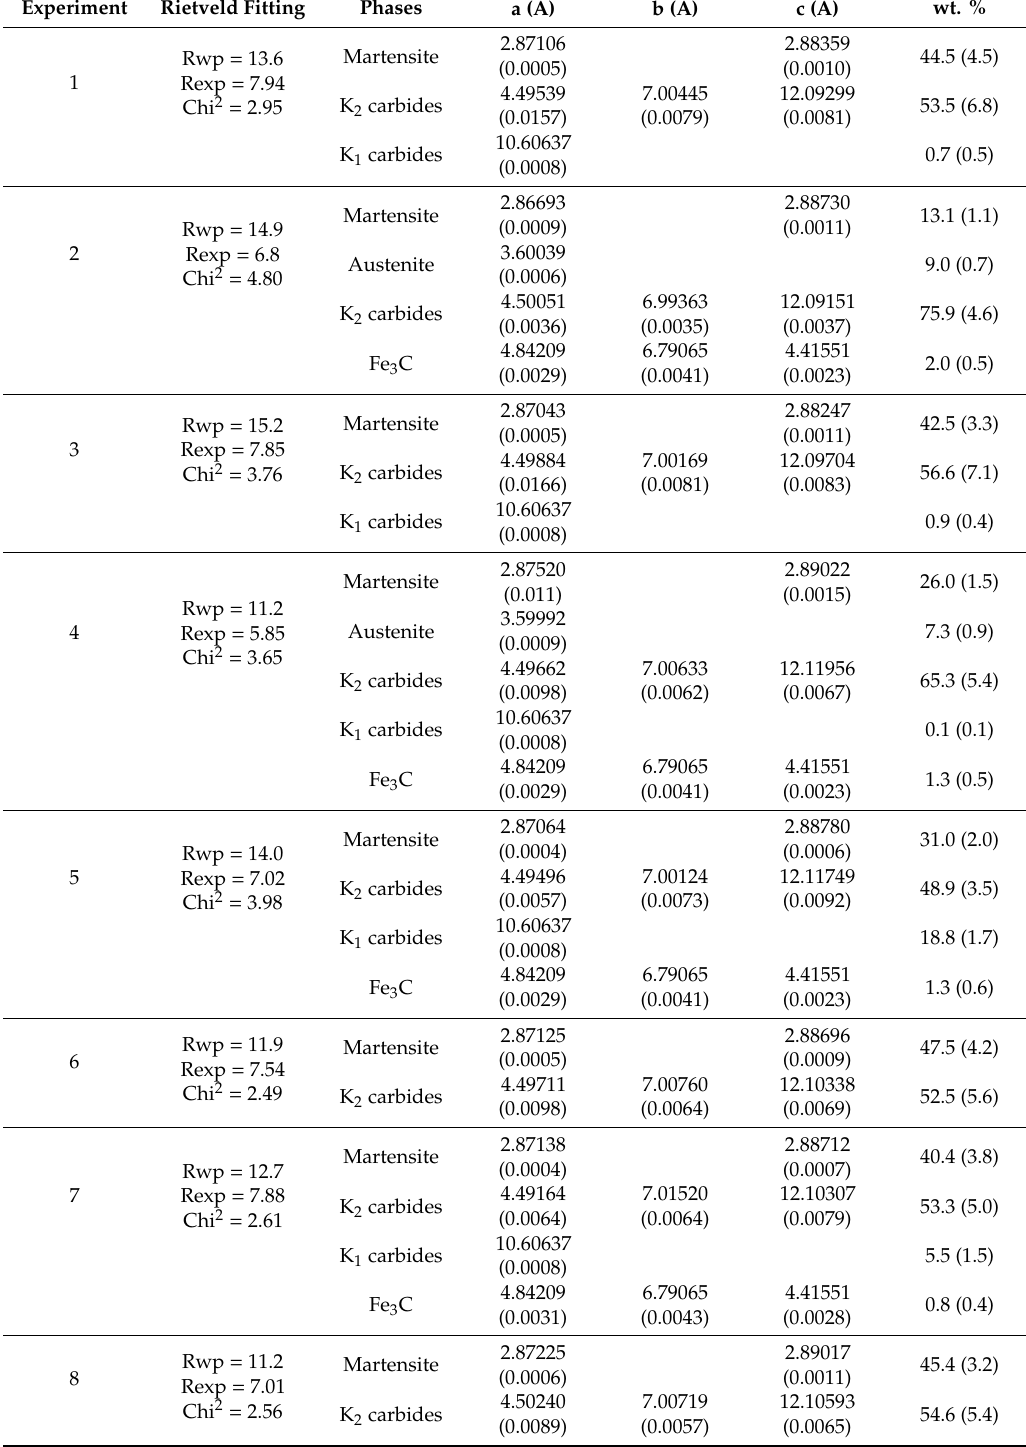
Table 7. Microstructural parameters, weight distributions of the precipitated phases, and volume of austenite. The statistical error is given between